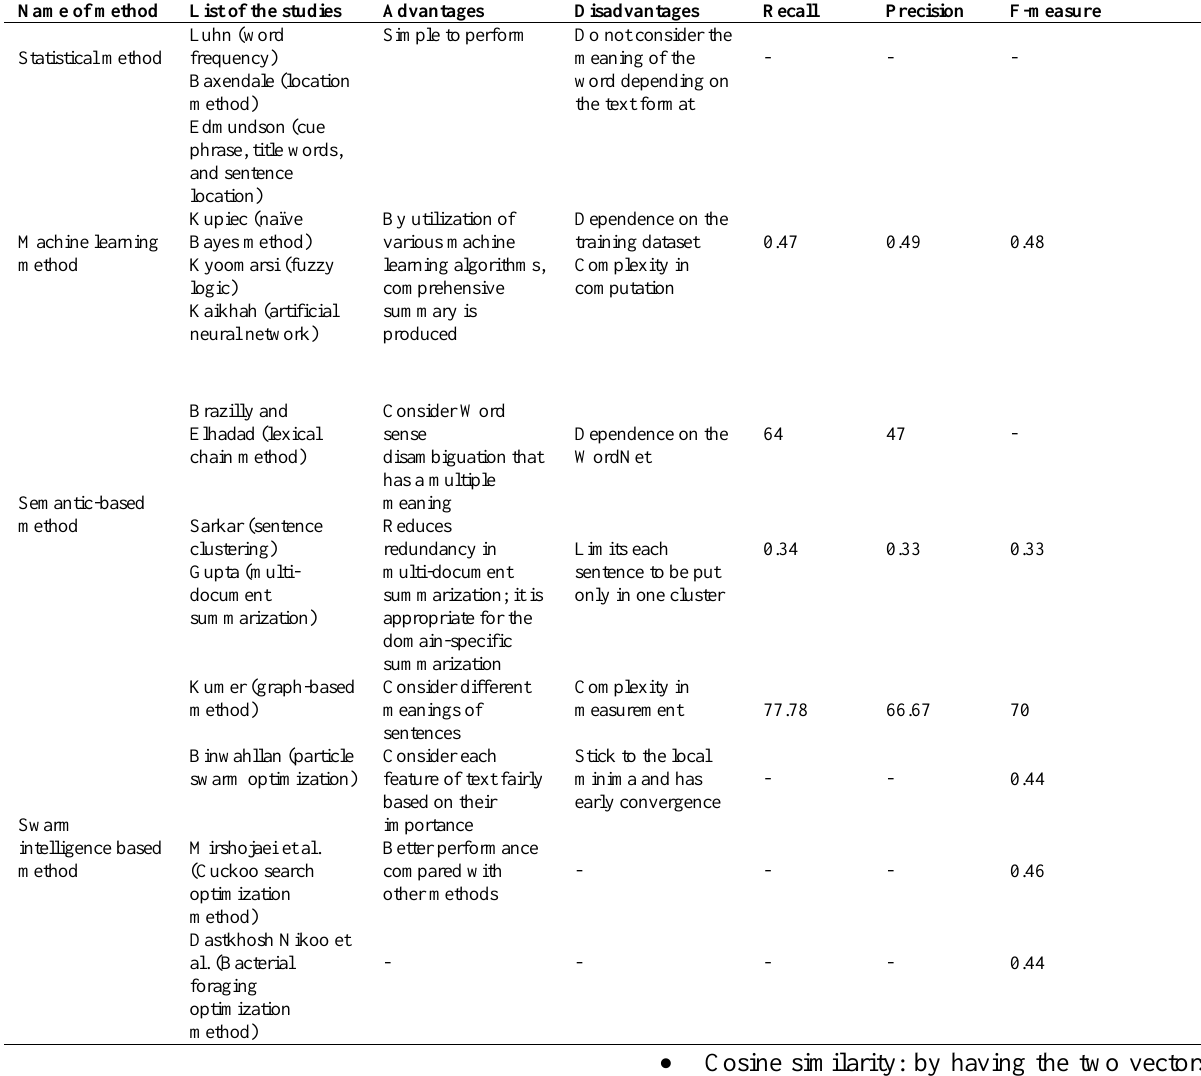
Table 1 : . Comparison between different